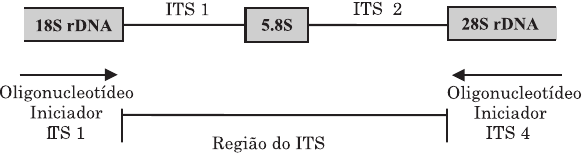
Figura 1. Região do rDNA com o espaço interno transcrito ITS1 e